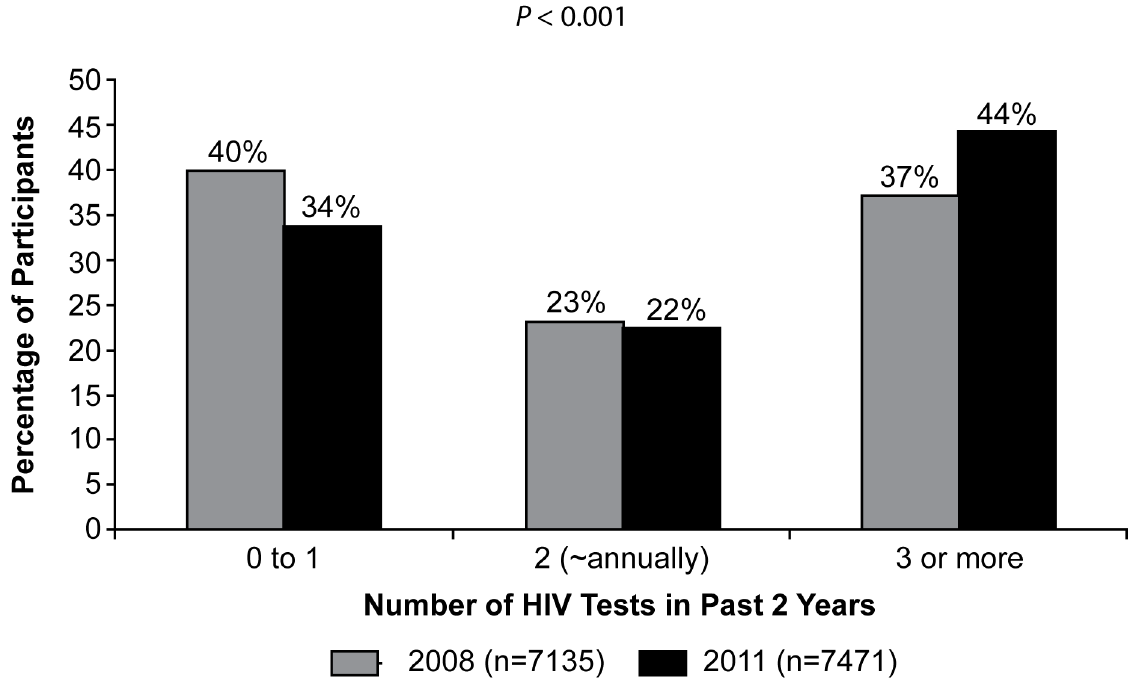
Figure 1. Number of HIV tests in a two-year period among MSM in 2008 and 2011. During the interview, NHBS participants were asked to report their HIV testing frequency in the two years before interview. Testing twice in a two-year period was used as a proxy for annual testing. The distribution of HIV testing frequency among MSM during the 2 years before interview, shown here, changed from 2008 to 2011 (P , 0.001). The percentage of men who tested one time or less in the 2 years before interview (less than annually) decreased from 40% in 2008 to 34% in 2011. The percentage who tested twice in two years (annually) was similar (23% to 22%), while the percentage of men who tested three or more times in two years (more than annually) increased from 37% to